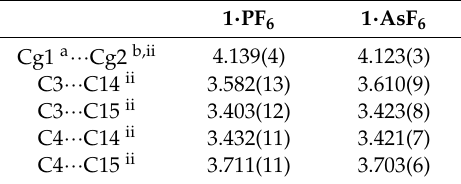
Table 3. Intermolecular contacts (Å) of π – π interaction for 1 · PF 6 and 1 · AsF 6 at 120